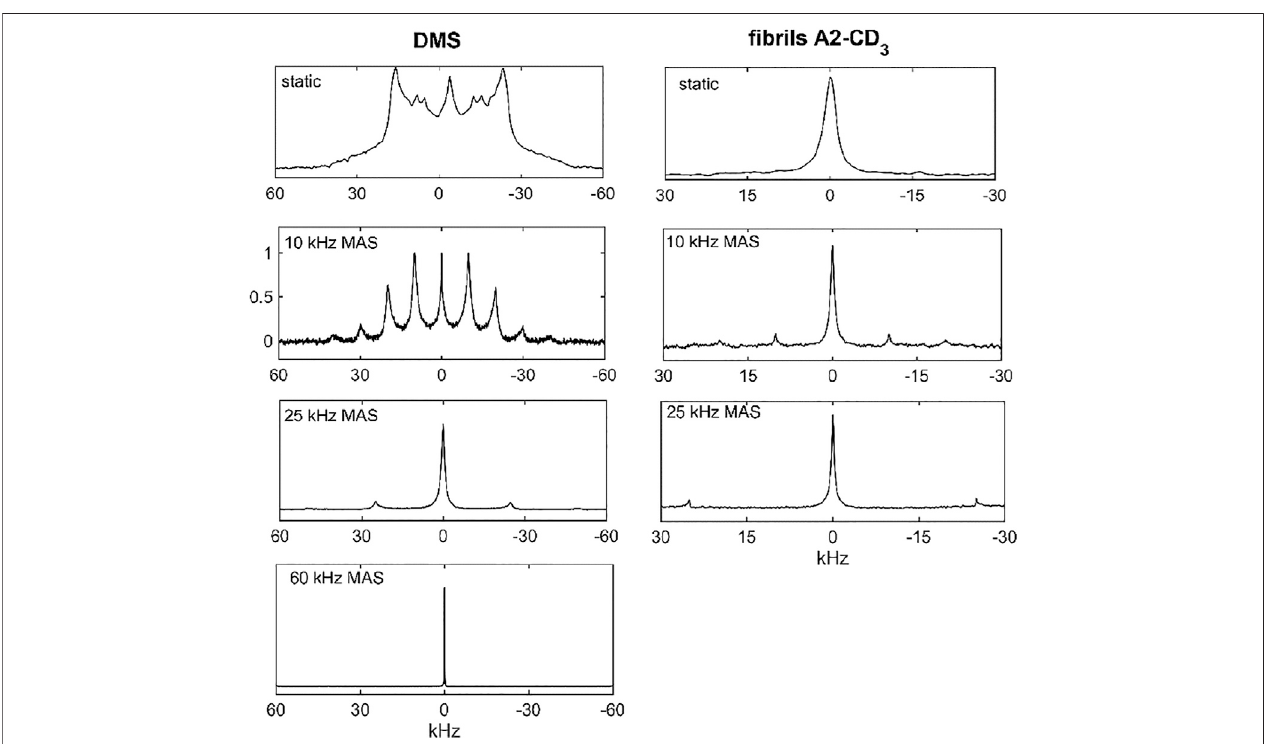
FIGURE 2| Spectra for DMS-D 6 (left column) and hydrated A β 1-40 fi brils in the 3-fold symmetric polymorph labeled at the A2-CD 3 site (right column). The following conditionsapplied:staticdata – 14.1Tand76 ° CforDMSand37 ° Cforthe fi brils;10and25 kHzMASrates – 17.6Tand76 ° CforDMSand37 ° Cforthe fi brils;60 kHzMAS rate for DMS only – 14.1 T and 55 ° C. The number of scans and processing parameters are listed in Supplementary Table S1